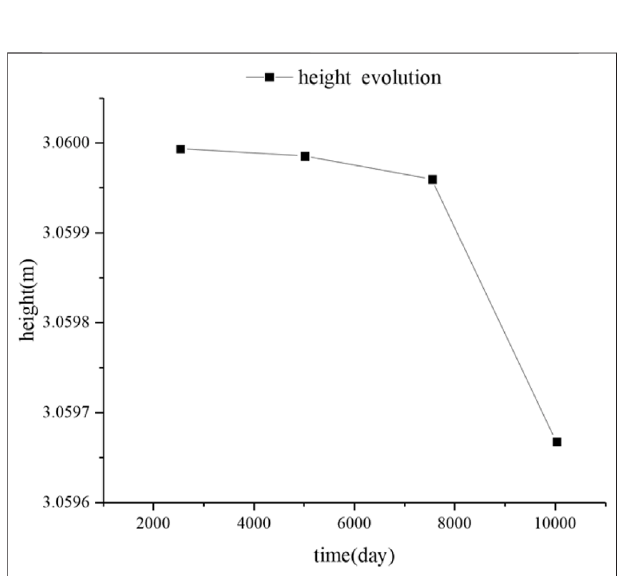
FIGURE 5 | Graph of height evolution with respect to